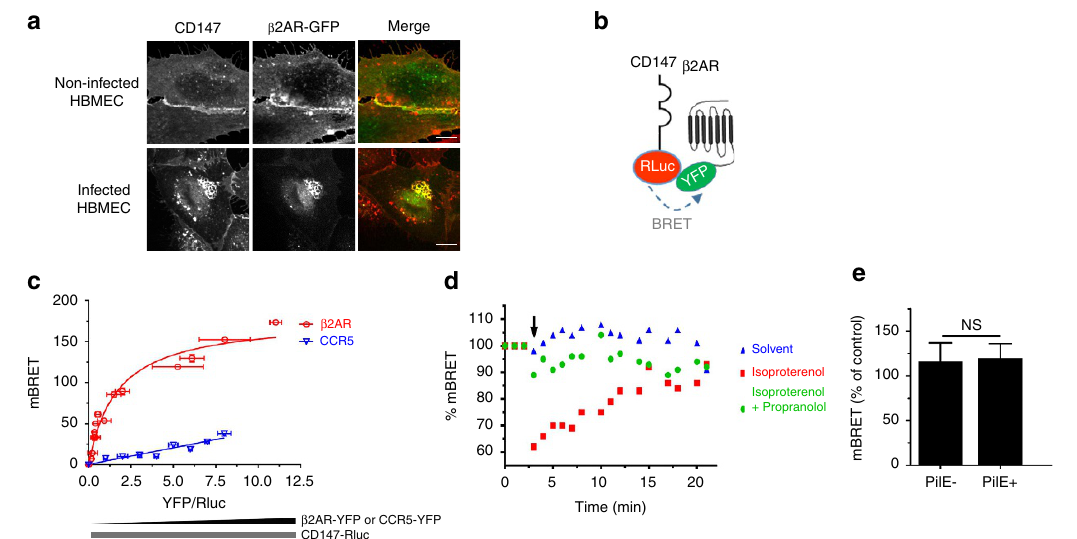
Figure 1 | CD147 and the b 2 -adrenergic receptor form hetero-oligomers. ( a ) CD147 and the b 2 AR colocalize at endothelial cell junctions and at sites of bacterial adhesion. HBMECs, transiently transfected with b 2 AR-YFP, were non-infected (top) or infected with meningococci for 2h (bottom). CD147 (red) and b 2 AR-YFP (green) receptor localization was analysed by confocal microscopy (scale bars, 10 m m). ( b ) Constructs used for BRETassays. CD147 fused to Renilla luciferase (CD147-Rluc) and b 2 AR fused to YFP ( b 2 AR-YFP) were used as energy donor and acceptor, respectively. ( c ) BRET analysis of CD147– b 2 AR interaction. HEK293 cells were transfected with CD147-Rluc (2ng) and increasing amounts (0–400ng) of b 2 AR-YFP or CCR5-YFP. At 24h after transfection, coelenterazine h (Rluc substrate) was added to measure the BRETsignal. Results correspond to one experiment (mean ± s.e.m., n ¼ 3) representative of five independent experiments. ( d ) Isoproterenol modified the BRET 50 . HEK293 cells were transfected with 2ng CD147-Rluc and 20ng b 2 AR-YFP, so that energy transfer was close to the BRET50 value. Coelenterazine h (Rluc substrate) was added to measure the basal energy transfer, then 10 m M isoproterenol alone or in combination with 10 m M propranolol, or solvent alone used as control, were added to cells and the energy transfer was measured every 2min for 20min. Arrow indicates time of injection of the different ligands. Results correspond to one experiment (mean ± s.e.m., n ¼ 3) representative of four independent experiments. ( e ) The meningococcal pilin PilE does not modify the BRET 50 . HEK293 cells were transfected with 2ng CD147-Rluc and 20ng b 2 AR-YFP, so that energy transfer was close to the BRET50 value. Coelenterazine h was added to measure the basal energy transfer, then purified meningococcal PilE was added and the transfer was measured every 2min for 30min. Results correspond to one experiment (mean ± s.e.m., n ¼ 3) representative of four independent